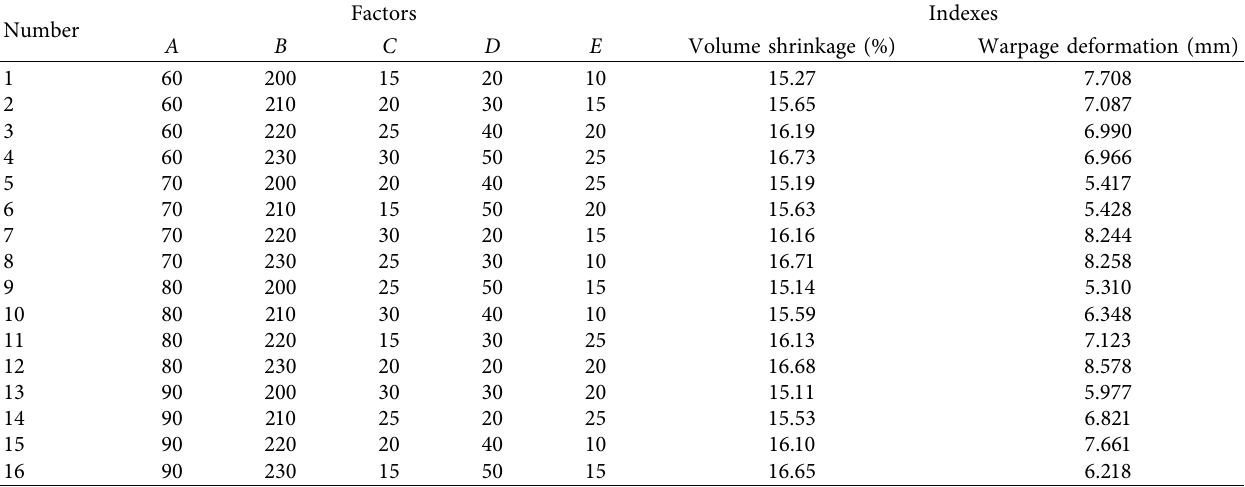
Table 4: Experimental design and results.